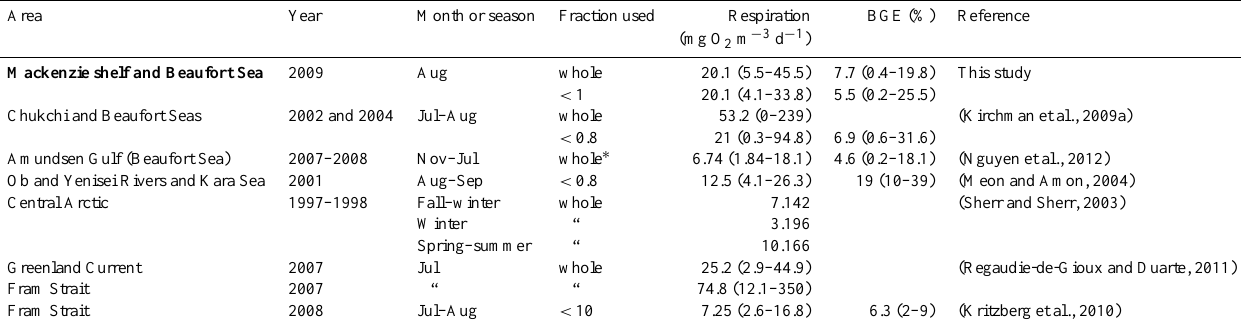
Table 5. Respiration measurements (total or with fractionation) and bacterial growth efficiencies (BGE) reported from the Arctic Ocean.